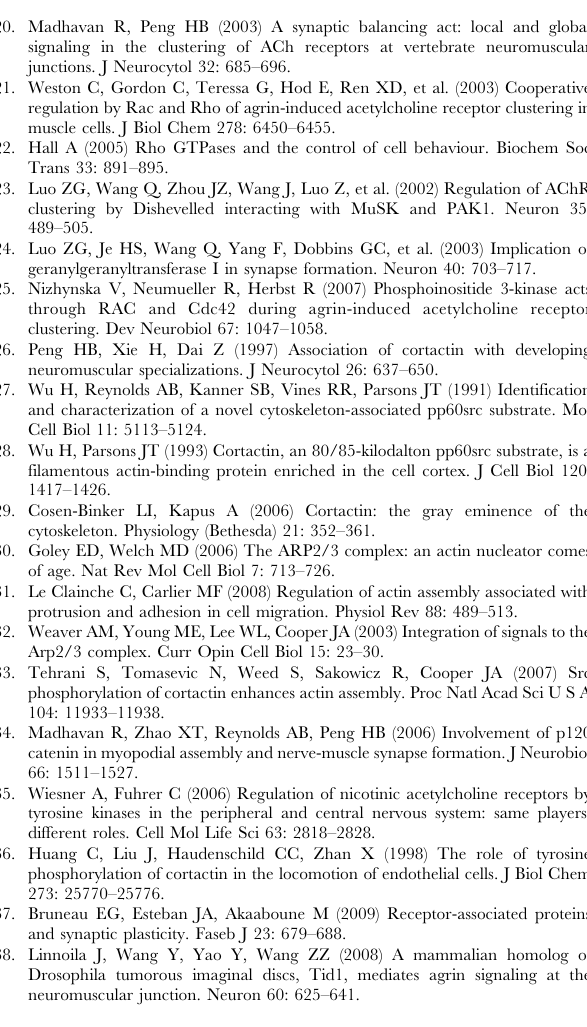
Table S1 Association of phospho-cortactin with AChR